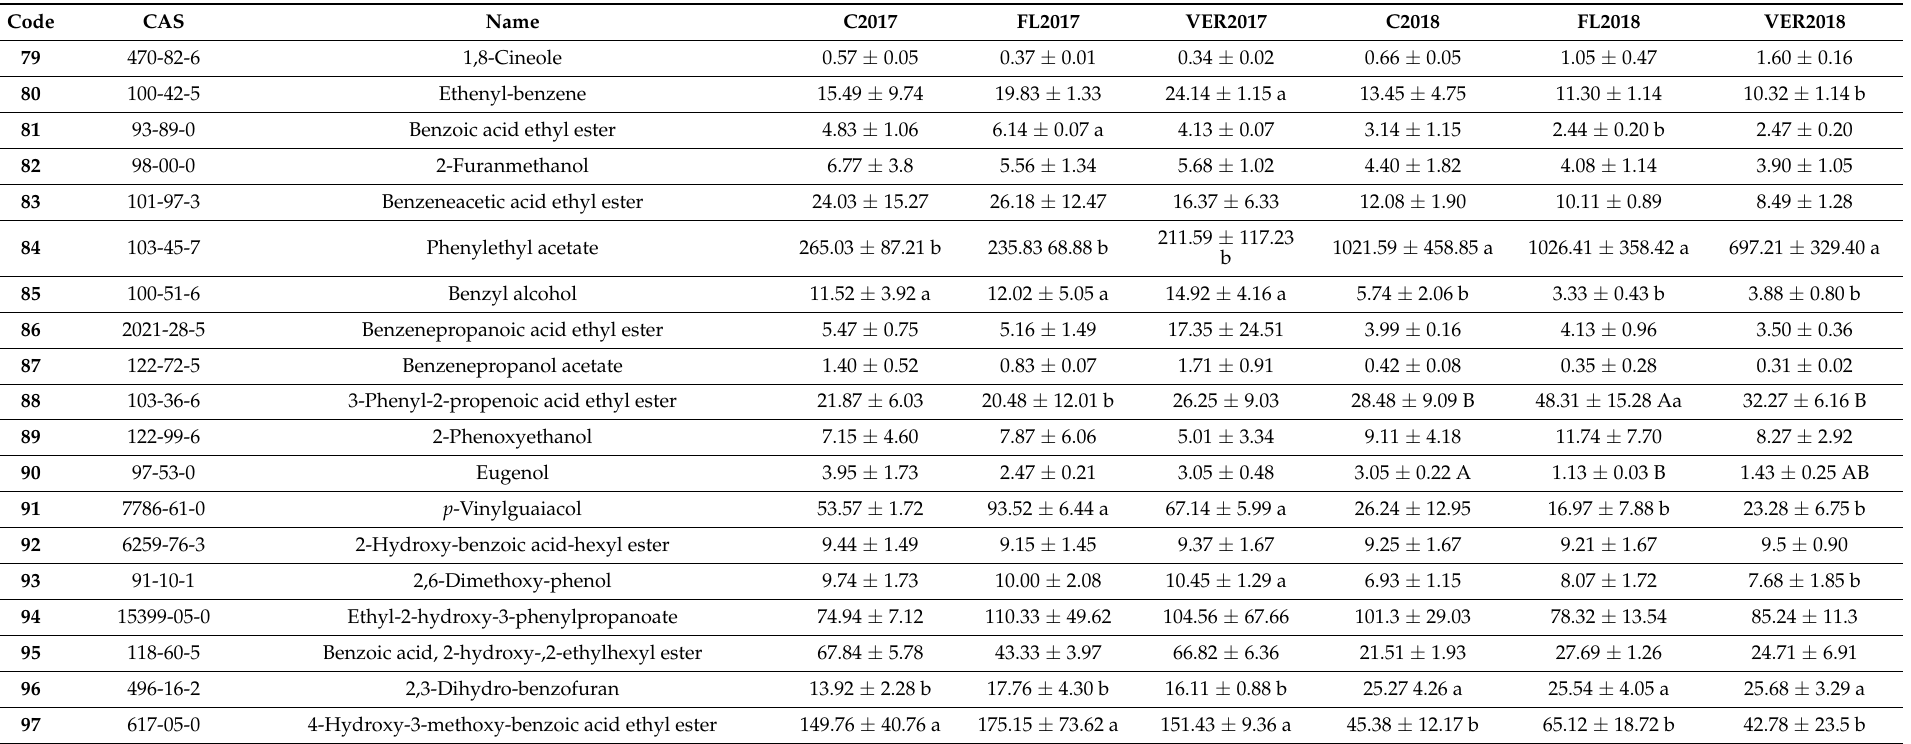
Table 5. Effects of defoliation treatments and vintage on concentrations of aromatic esters and aromatic alcohols ( µ g/L). (The quantification was conducted by using a linear standard calibration with 2-phenylethanol.) C = control; FL = removal of six leaves before flowering; VER = removal of six leaves at the end of